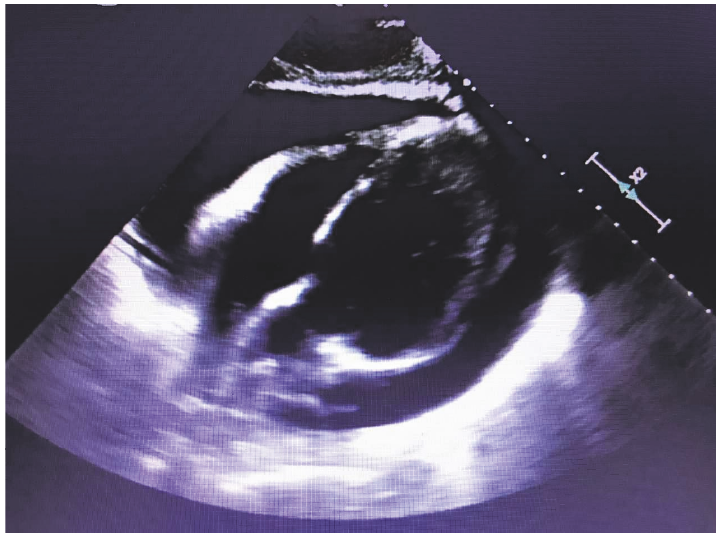
Figure 4: Echocardiogram prior to pericardial drain placement showing large pericardial